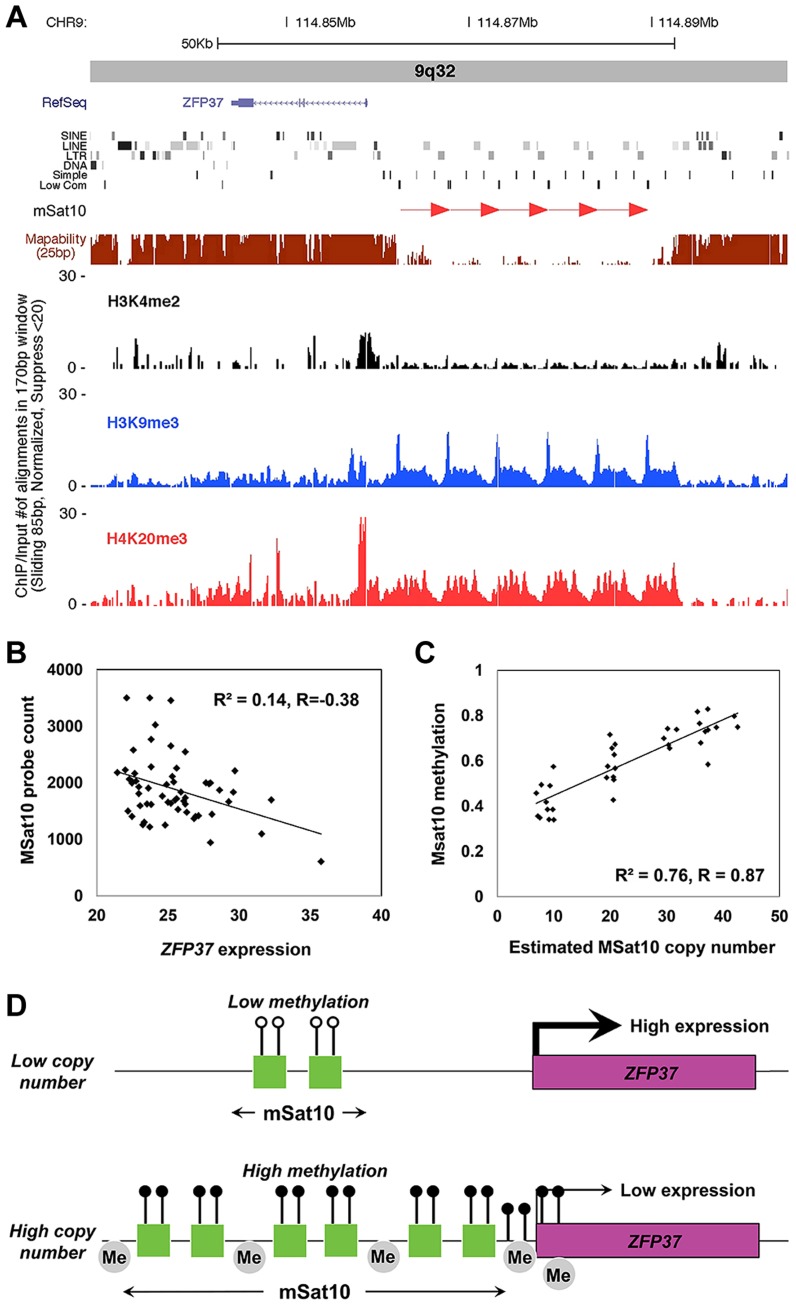
Association of MSat10 copy number with neighboring gene expression and epigenetic marks.(a) MSat10 is a 5.2 kb GC-rich tandem repeat that lies ∼4 kb distal to the gene ZFP37. Although 6 copies of this 5.2 kb repeat are present in the hg18 assembly this macrosatellite is highly polymorphic in size, varying from 4–42 copies in HapMap. ChIP-seq analysis shows the presence of histone marks characteristic of heterochromatin, such as trimethylation of histone H3 at lysine 9 and trimethylation of histone H4 at lysine 9. Screenshot from the UCSC Genome Browser shows ZFP37 (Zinc Finger Protein 37), the adjacent MSat10 repeat (red arrows), and the results of ChIP-seq analysis. (b) In 58 unrelated CEU HapMap individuals we observed an inverse correlation between copy number of the MSat10 repeat and expression level of the adjacent gene ZFP37, demonstrating suppression of ZFP37 expression associated with larger repeat sizes (c) Using a targeted Sequenom assay, we confirm that variable methylation of MSat10 is highly correlated with repeat number (R2 = 0.76, p = 4.4×10−12), showing a strong relationship between repeat size and local epigenetic state. (d) Proposed model of repeat induced gene silencing at the MSat10 locus. At low repeat numbers the region is euchromatic and the expression of the neighboring ZFP37 gene is high. However, expansions of the macrosatellite result in an accumulation of heterochromatic marks in the region, including repressive histone modifications and DNA methylation, resulting in the suppression of local gene expression. Although our model shows methylation on all MSat10 copies, our data does not exclude the possibility that on expanded MSat10 alleles DNA methylation is limited to a subset of the repeat units. Lollipops represent DNA methylation, with open circles being low and filled black circles high DNA methylation, and grey ‘Me’ bubbles represent repressive histone methylation.